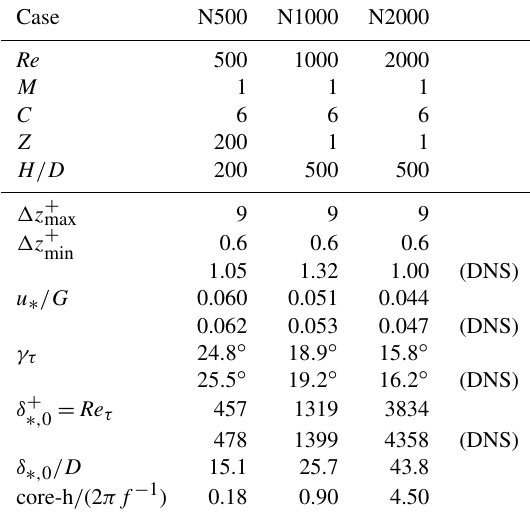
Table 2. Details of the ODT simulation cases for neutral Ekman flow with comparison to reference